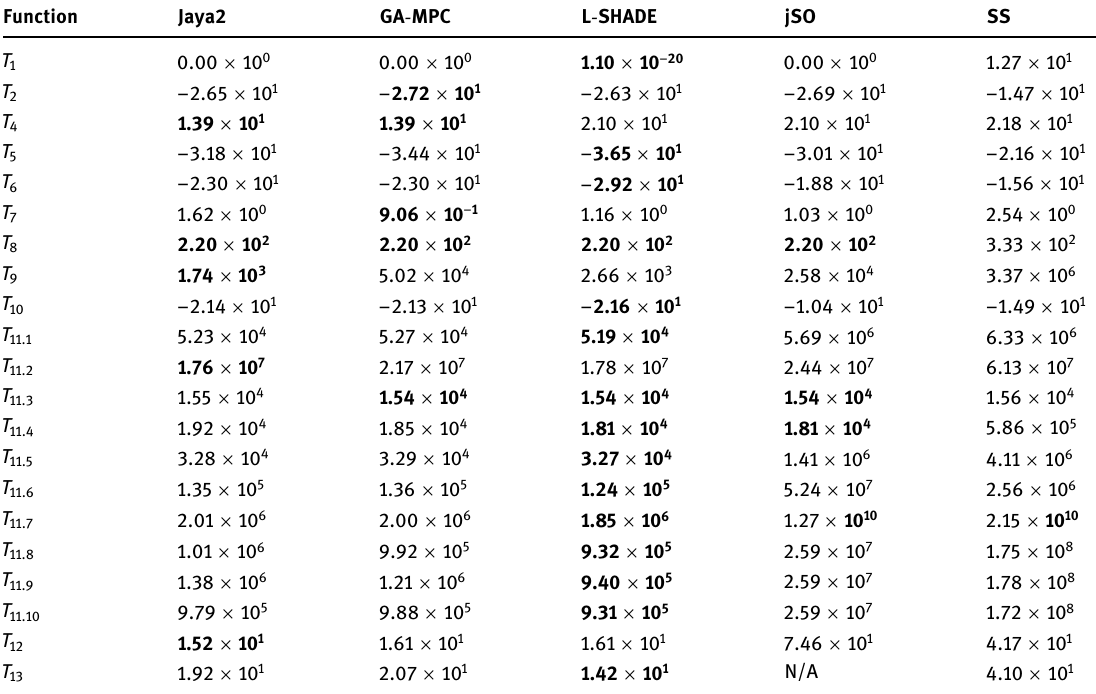
Table 16: The CEC 2011 median function values achieved by Jaya2, GA - MPC, L - SHADE, jSO, and SS over 25 runs and 150,000 function evaluations